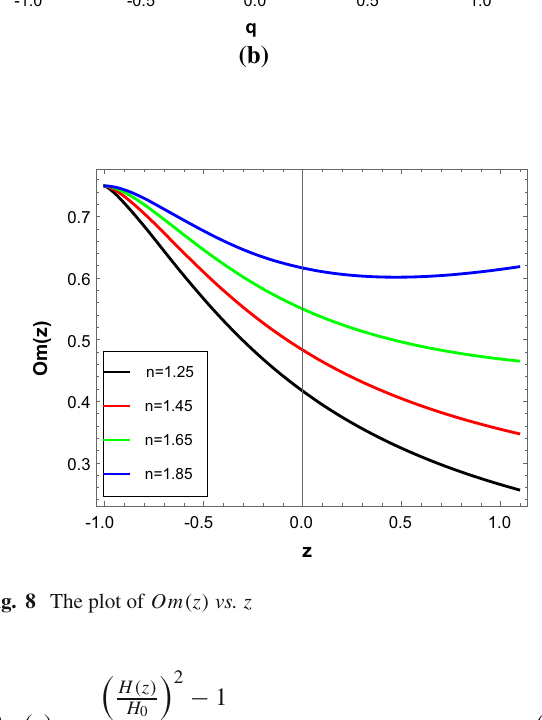
Fig. 8 The plot of Om ( z ) vs. z